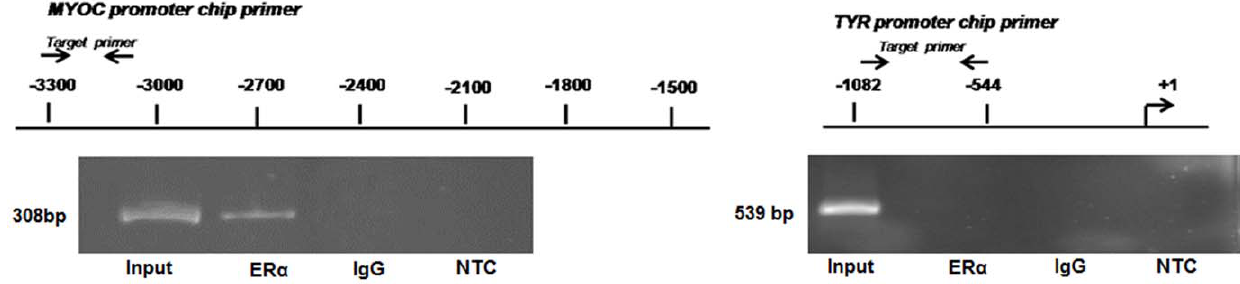
Figure 6. Direct binding of ER- a - 17 b estradiol complex to EREs in MYOC promoter. ChIP (Chromatin-immunoprecipitation) assay results showing the presence of specific 308 bp band for myocilin promoter in the sample immunoprecipitated with the anti-estrogen receptor antibody. No specific band was observed for Tyrosinase gene promoter devoid of any EREs. In both the cases no amplification was observed on immunoprecipitation with immunoglobulin (IgG). Three independent replicates were performed for this experiment. NTC: No Template